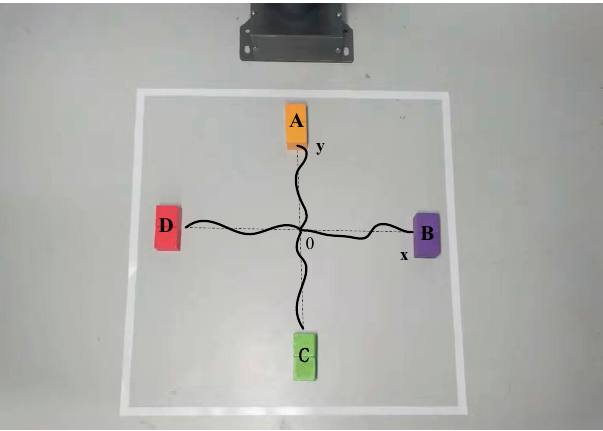
Figure 13. Target distribution, coordinate system, and an example trajectory of the robotic arm.